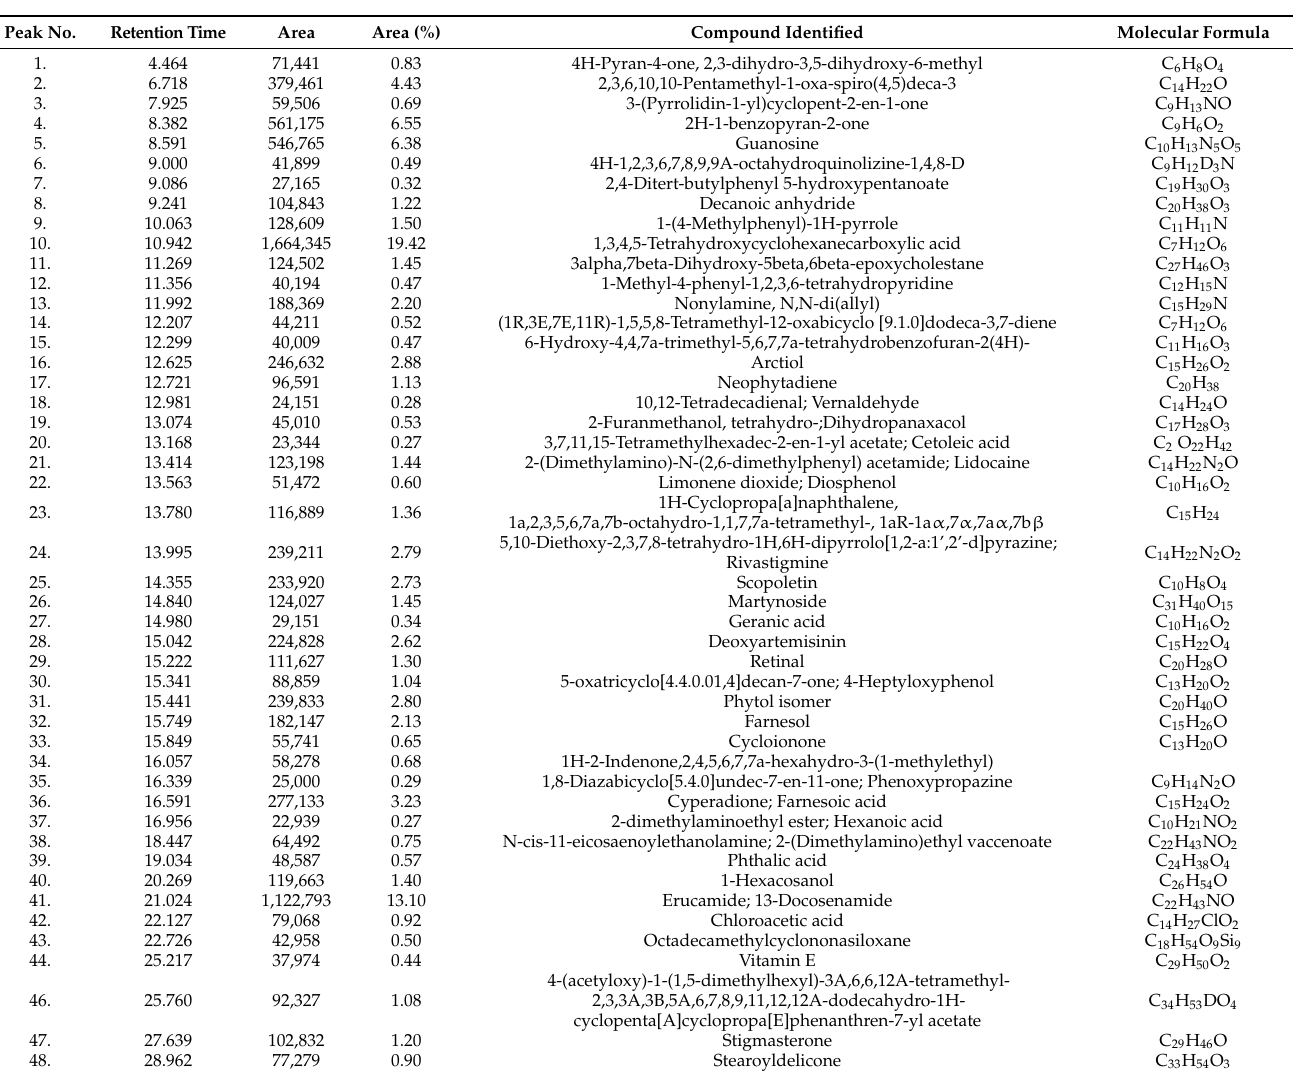
Table 2. Bioactive constituents recognized in the ethanolic extract of A. vulgaris L.